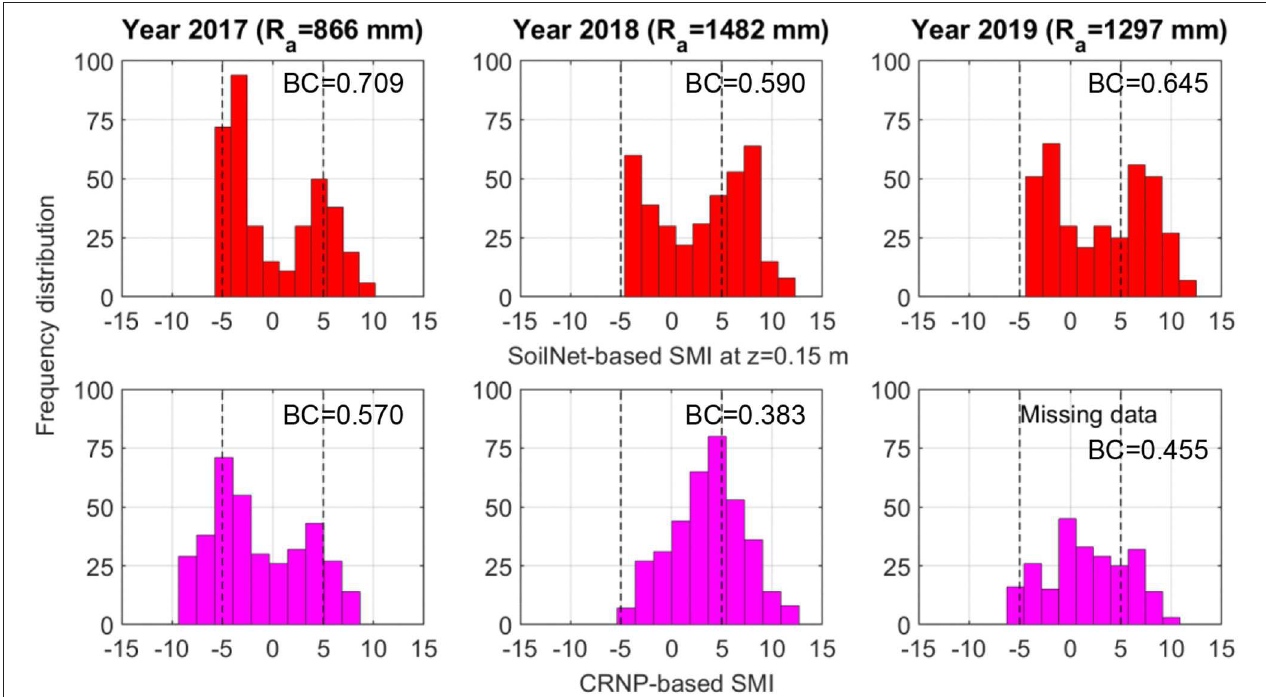
FIGURE 9 | Frequency distributions of daily values of SMI (SMI d ) calculated using SoilNet-based soil moisture at z (magenta bars) at MFC2 in 2017, 2018, and 2019. Each subplot reports the bimodality coefficient